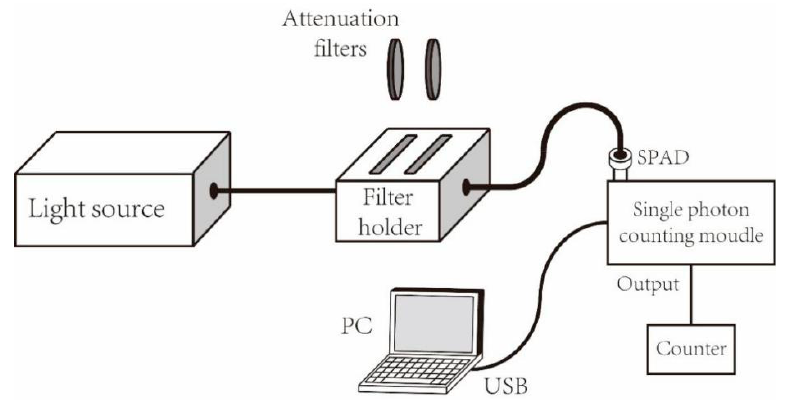
Figure 6. Experimental setup for the dark count rate and photon detection efficiency measurement.